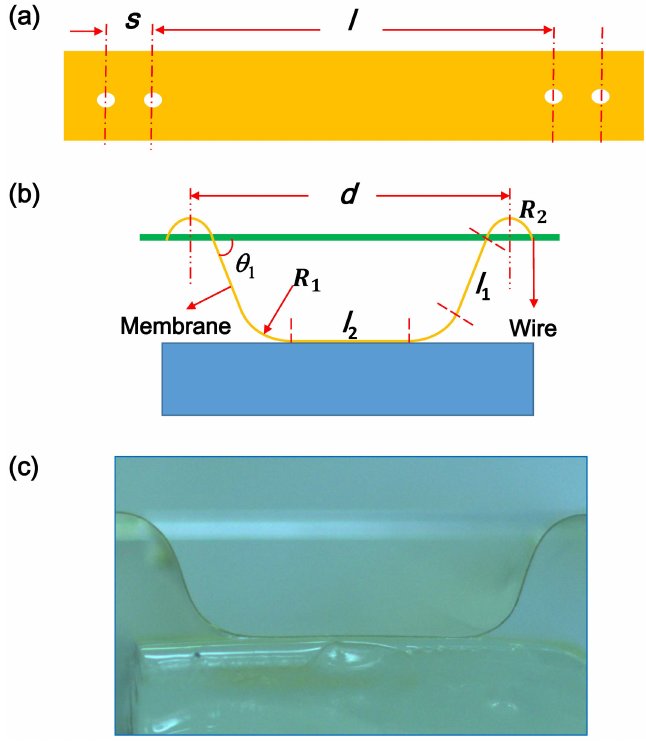
Figure 2. Geometric model of the membrane in contact with a featureless flat surface. ( a ) Top view of the membrane in a released state; ( b ) side view; ( c ) optical image of the membrane in its side